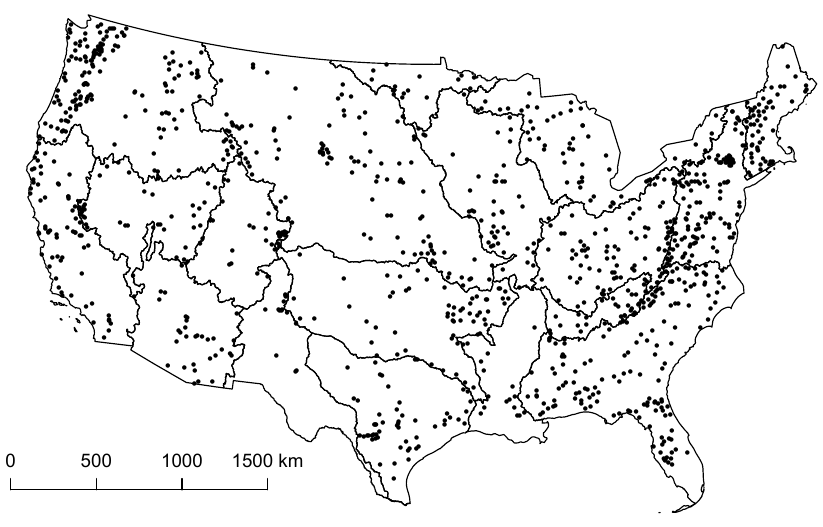
Figure 1. Map of the locations of 1168 reference quality streamgages from the GAGES-II database (Falcone, 2011) used for analysis. All streamgages used have more than 14 complete water years between 1 October 1980 and 30 September 2013. The outlines of two-digit hydrologic units, which define the regions used here, are provided for further